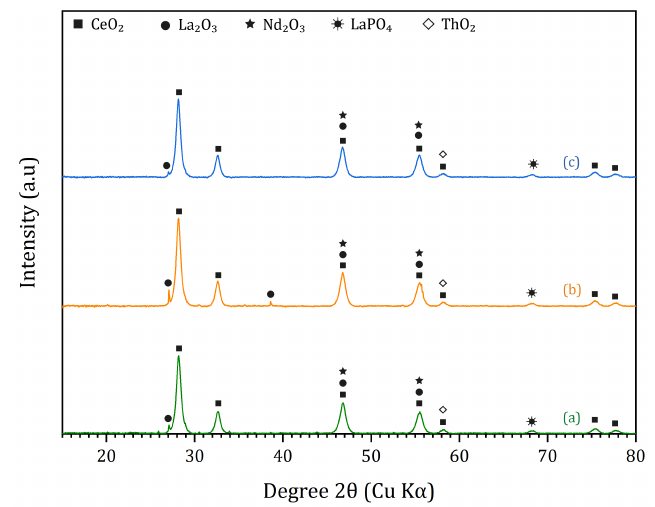
Figure 11. Effect of roasting temperature with KOH on the dephosphorization of monazite concentrate at times of 60, 90, and 120 min.